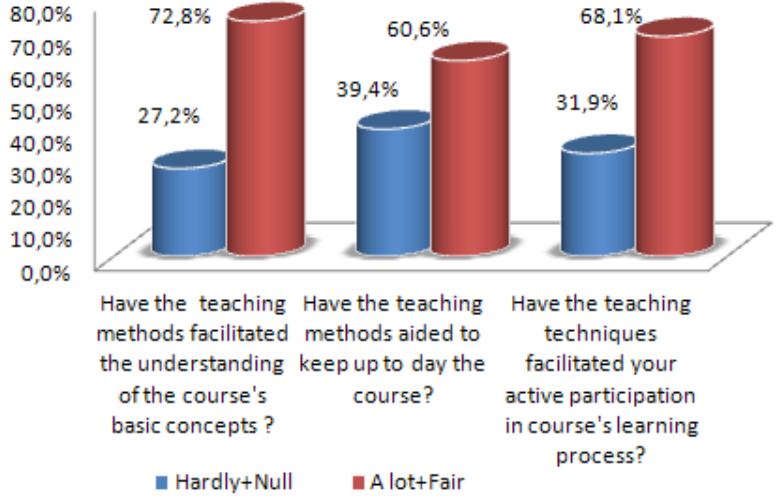
Fig. 4. Degree of satisfaction results with the teaching methodologies